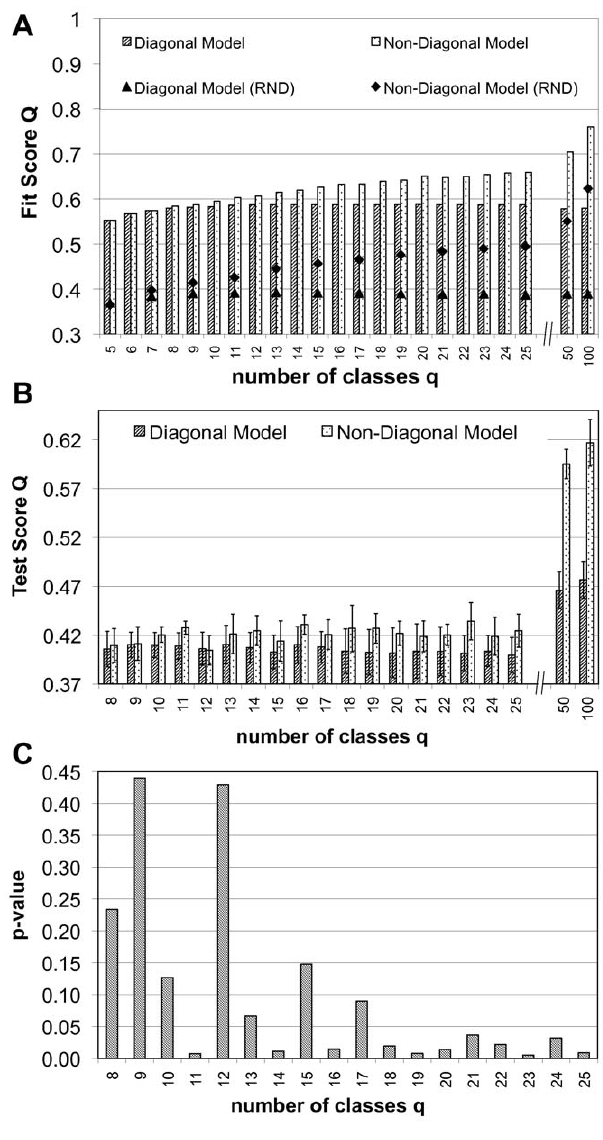
Figure 3. Fit scores and generalization error. A Comparison of highest fit scores Q N (4) and Q (cid:1) (5) for the full HPRD dataset with 32,331 interactions. Aggregating nodes into cohesive groups (diagonal image graphs) cannot improve the score beyond a certain limit, while non-diagonal image graphs are able to capture more and more structure as the image graph gets larger and larger. For comparison, the analysis was repeated on a randomized (RND) version of the original network. Standard deviation is smaller than symbol size. The fit scores we obtain on the real data show that the structure we find is far from random. B After removing a test-set of links from the network, we optimized the assignment of nodes into classes according to (2) using only the remaining links and keeping the image graphs fixed to those found in the runs that lead to figure A. With the assignment of nodes into classes for this training set of links, we computed the score on the test set of links. The figure shows average and standard deviation over 10 repetitions of this experiment. C p-values of Student’s t-test for a statistically significant difference in the means of the test scores of panel B. For higher numbers of classes and thus larger differences in the fit scores of diagonal and non-diagonal image graphs, all differences become significant at the 5% level.